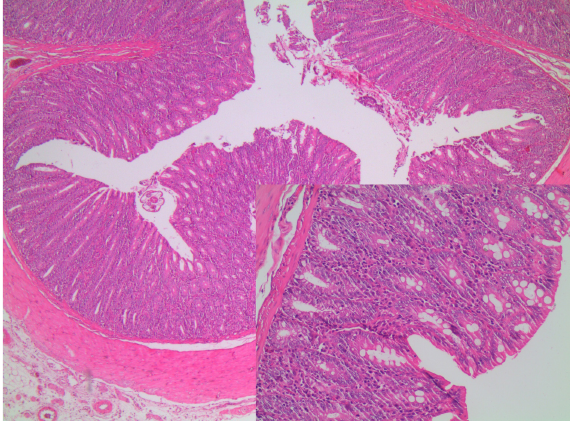
Figure 2. Acetic acid group on day 7, mild lymphocyte increase in lamina propria (H&E, × 40 and × 200). H&E, hematoxylin and eosin.